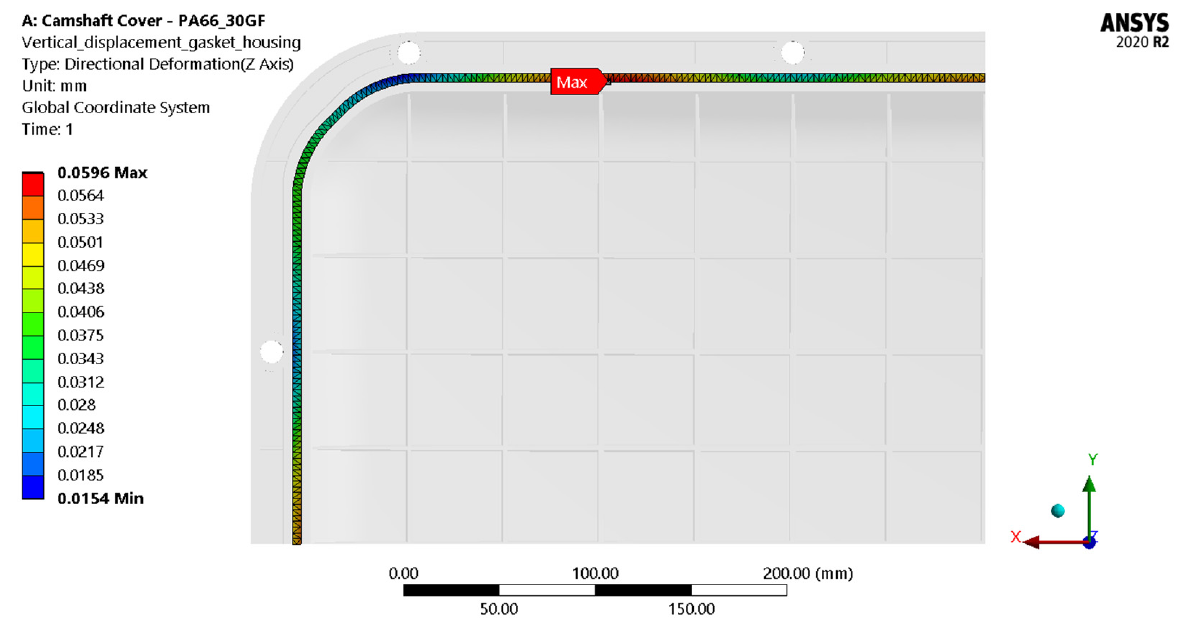
Figure 8. FEA results: vertical displacement on the gasket housing.